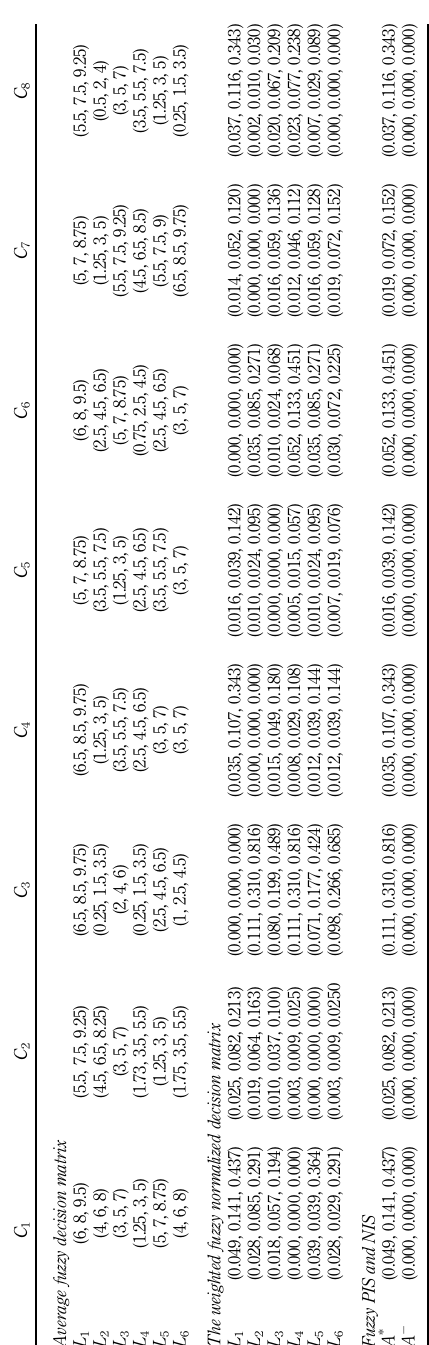
Table 4. FPIS and FNIS values of